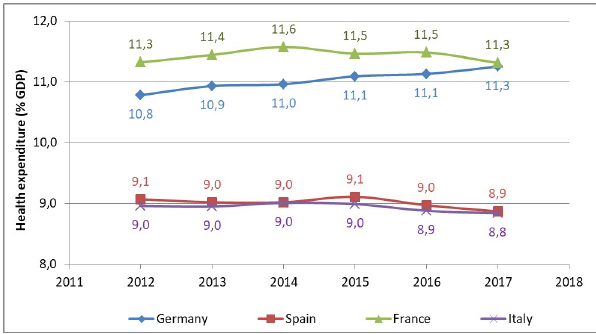
Fig 2. Health expenditure (public and private) reported as percentage of the GDP.